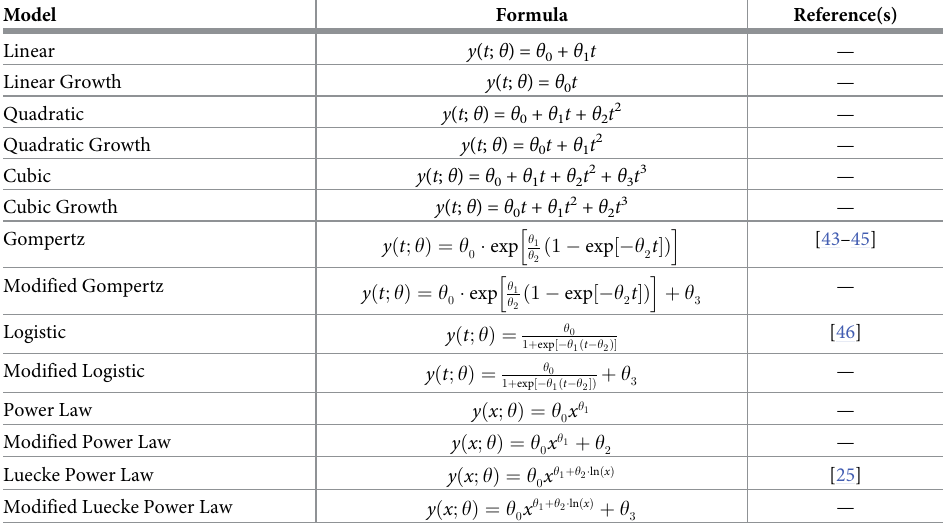
Table 3. Types of models used to describe changes in masses, volumes, percentages, and physiological rates during pregnancy and